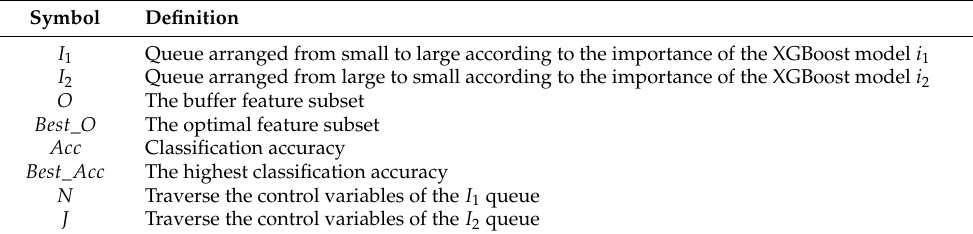
Table 6. The definition of the XGBIBS